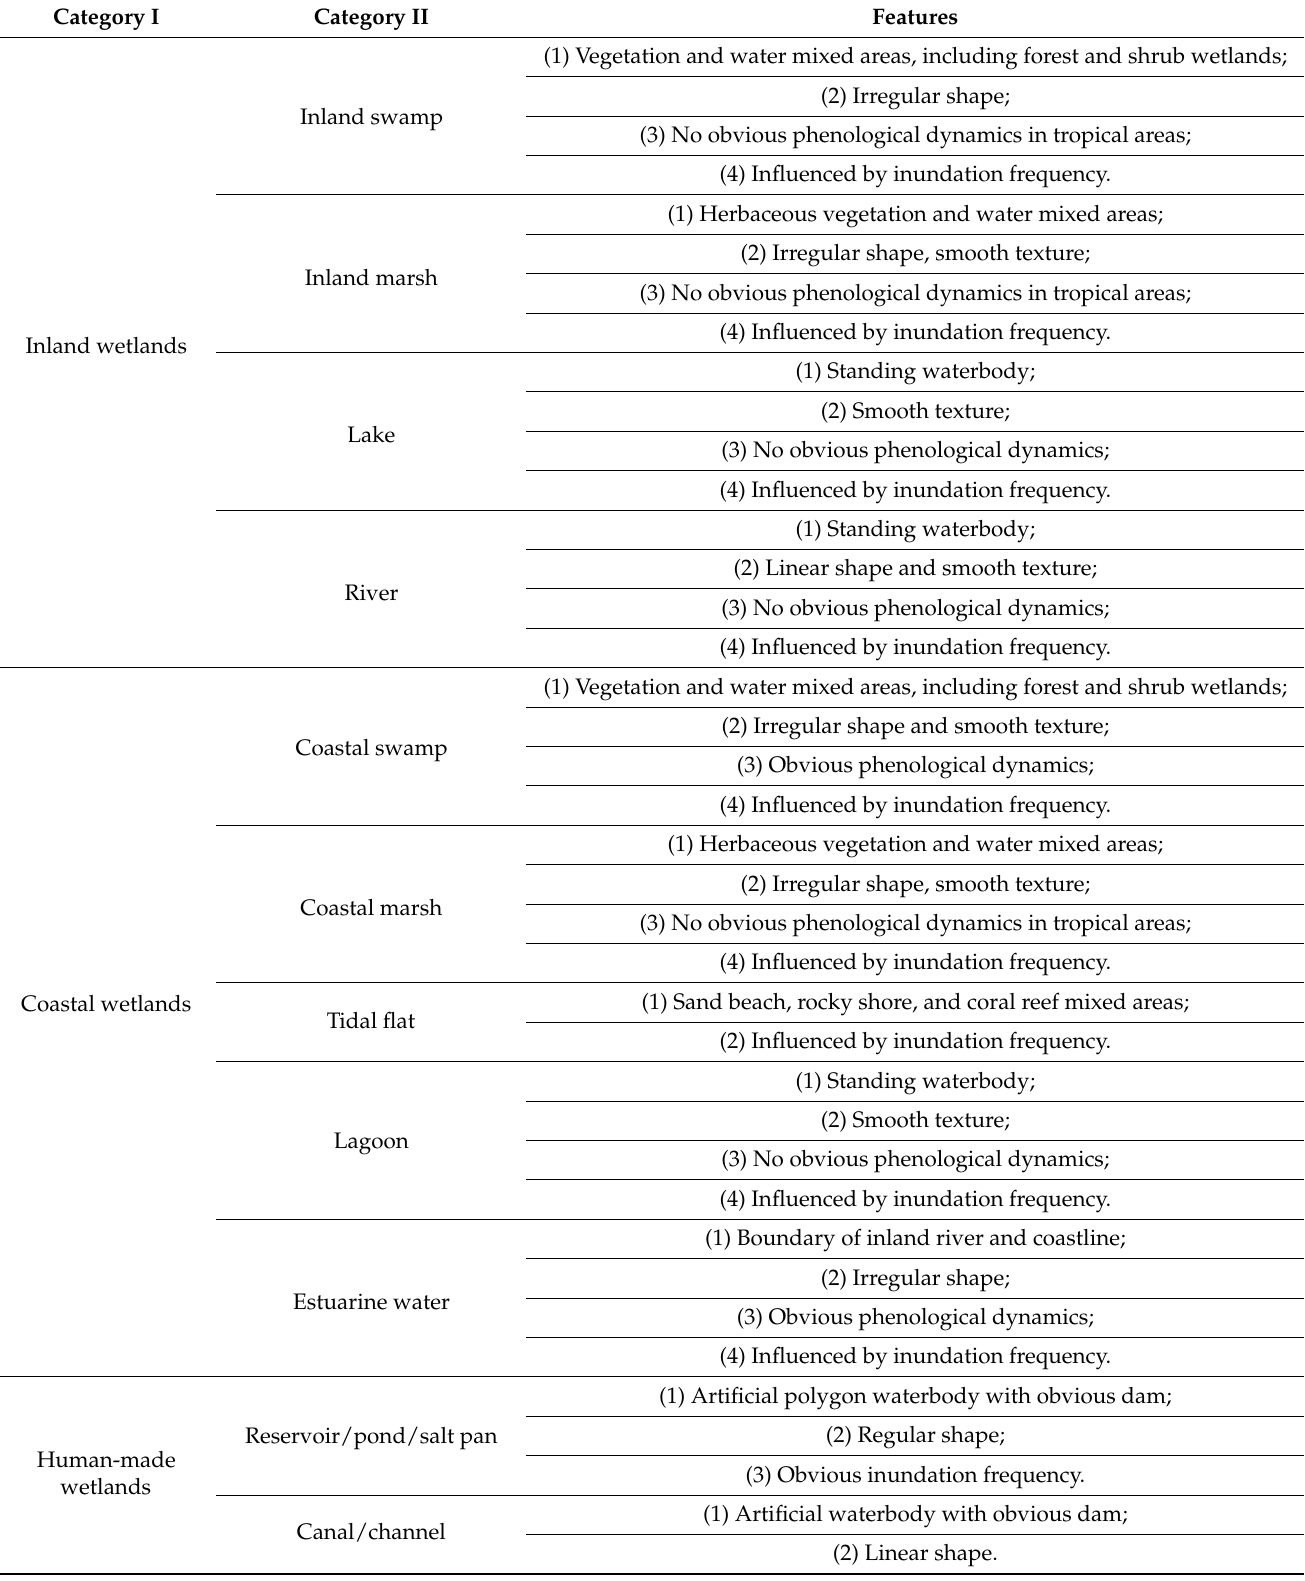
Table 1. The Southeast Asia wetland cover map classification